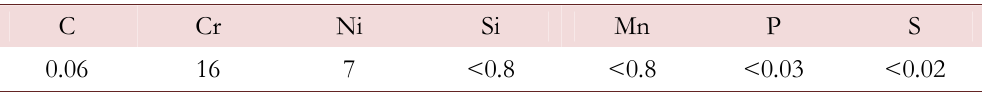
Table 1: Chemical composition of high strength steel (weight